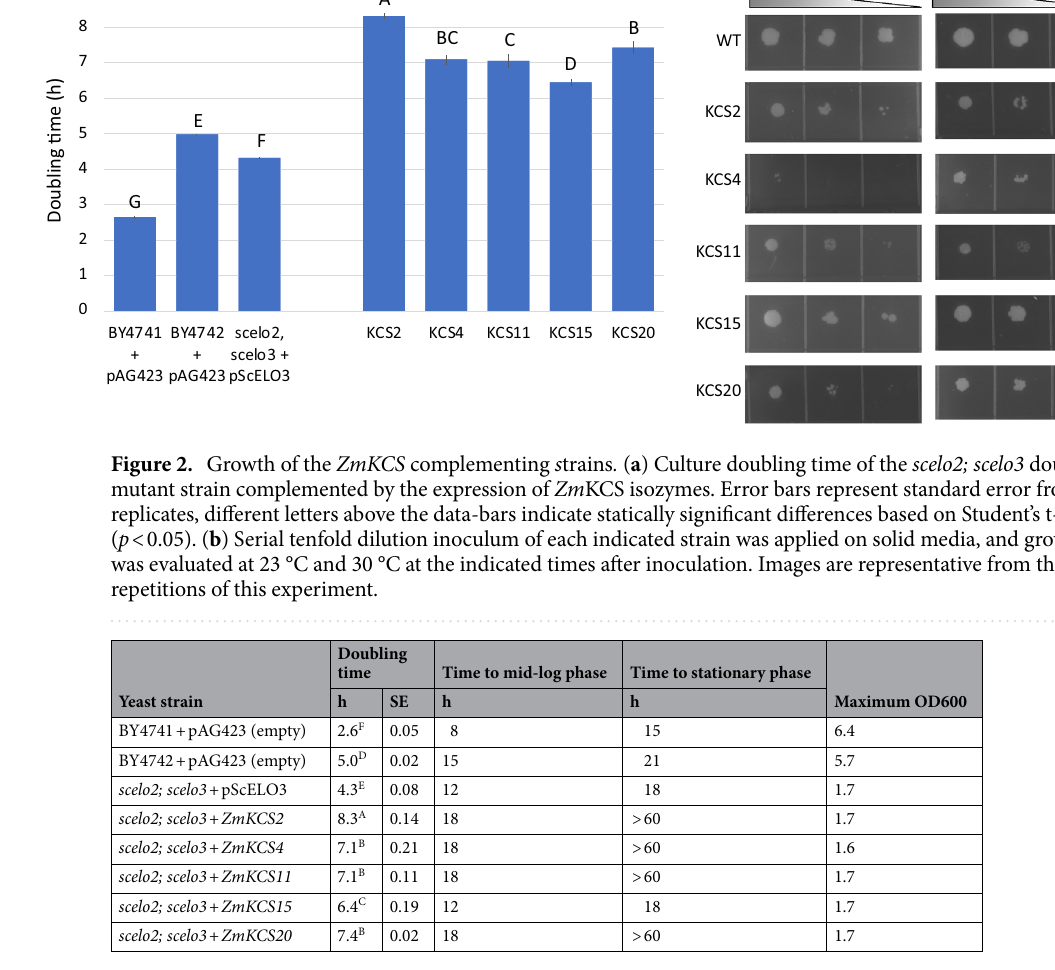
Table 1. Growth characteristics of the ZmKCS complementing strains. Data were collected from strains grown in liquid cultures as described in the “Methods” section. Doubling time is the average from 3 replicate experiments ± standard error (SE), and different superscript letters ( A-F ) indicate statistically significant differences among the strains based upon Tukey HSD ( p value < 0.05). The ANOVA F-ratio (240.2) and F-value (< 0.0001) were assessed prior to Tukey HSD.